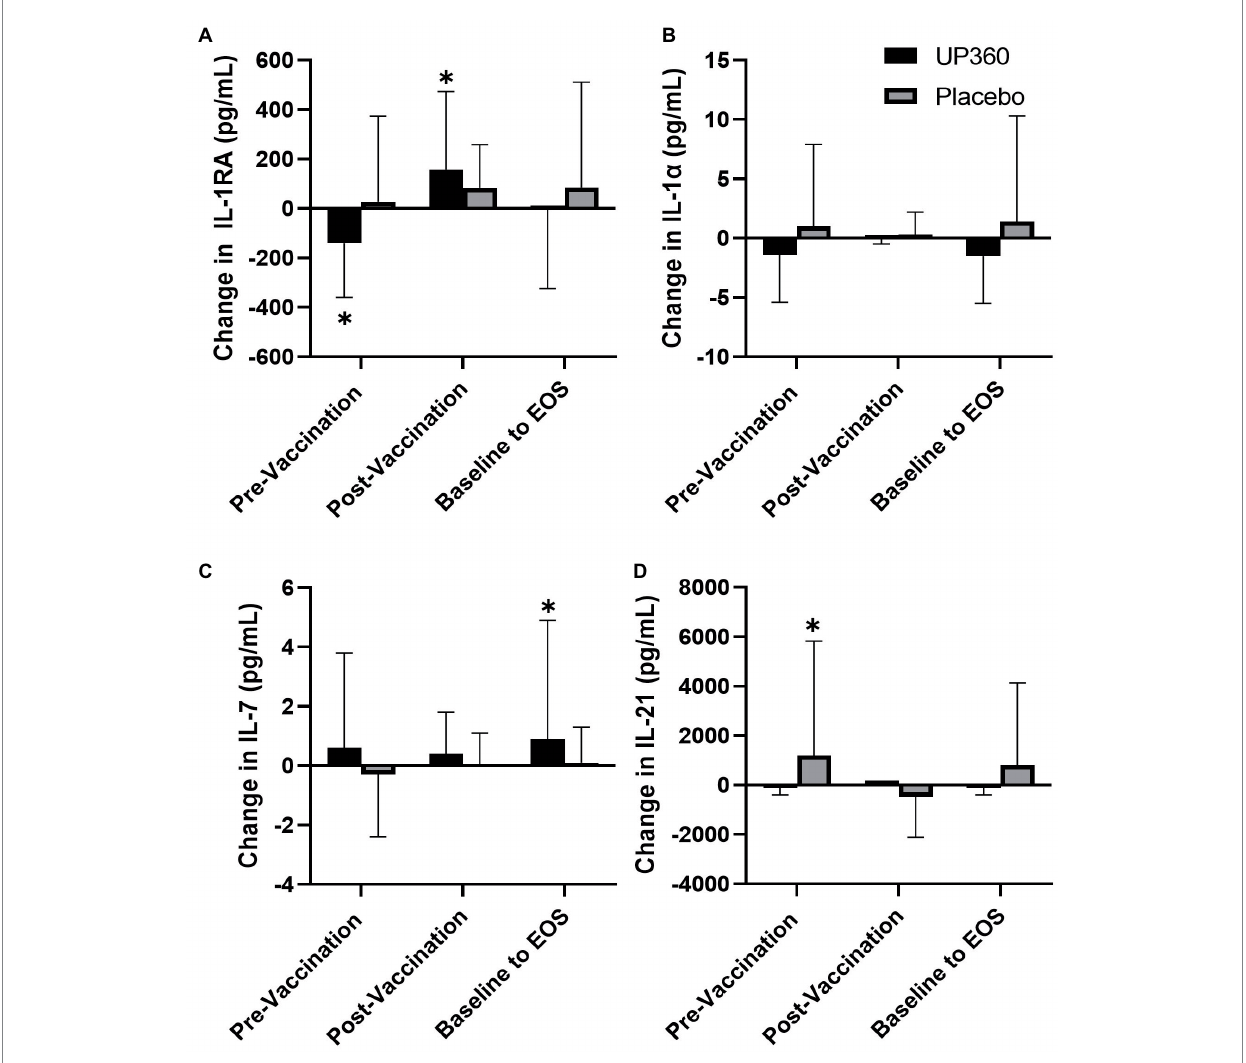
FIGURE 2 Change in the serum concentration of (A) IL-1RA, (B) IL-1 α , (C) IL-7, and (D) IL-21 between UP360 and Placebo in the pre-vaccination period (baseline to Day 28), post-vaccination period (Day 28 to Day 56) and from baseline to end-of-study (EOS, Day 56) in the ITT population ( n = 50). Values presented are mean ± standard deviation (SD). *indicates a significant difference within-group at the specified